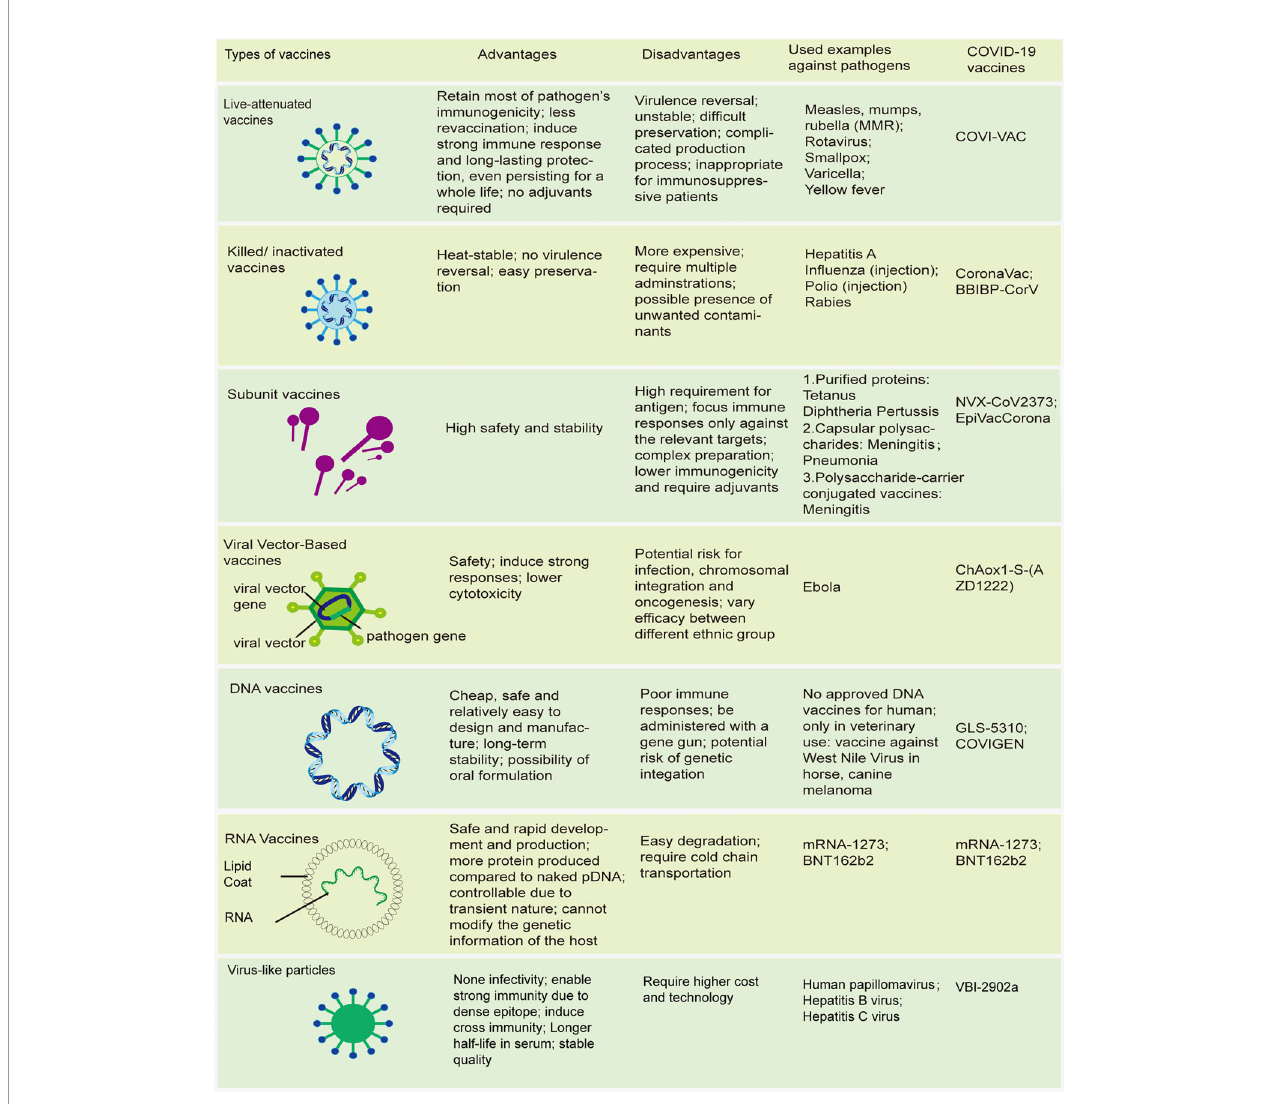
FIGURE 1 | Modern vaccines. Schematics of different types of vaccines; advantages and disadvantages of these vaccines; some traditional vaccines licensed by FDA; novel types of COVID-19